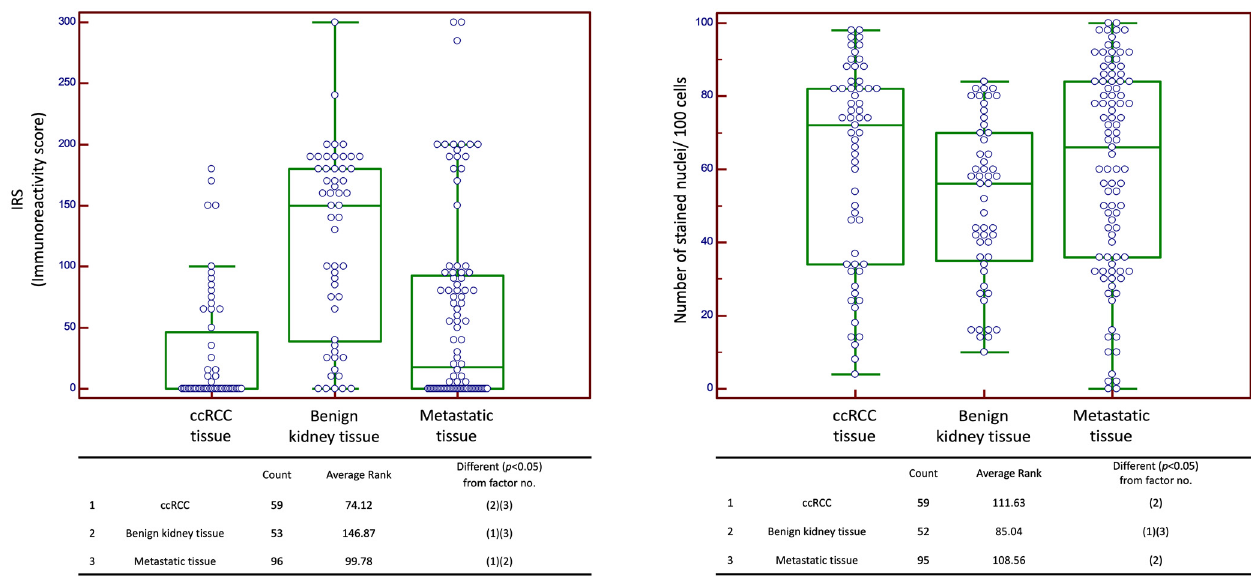
Figure 4. Cytoplasmic and nuclear expression scores for combined cohort of n 1 and n 3 . The evaluated samples represent ccRCC samples with their corresponding benign tissue from cohort n 1 and histologically confirmed ccRCC metastases from cohort n 3 . Abbreviations: IRS: immunoreactivity score; ccRCC: clear cell renal cell carcinoma. Green box represents median and 1st and 3rd quartile. Purple circles are individual values, circles outside the box are outside values.